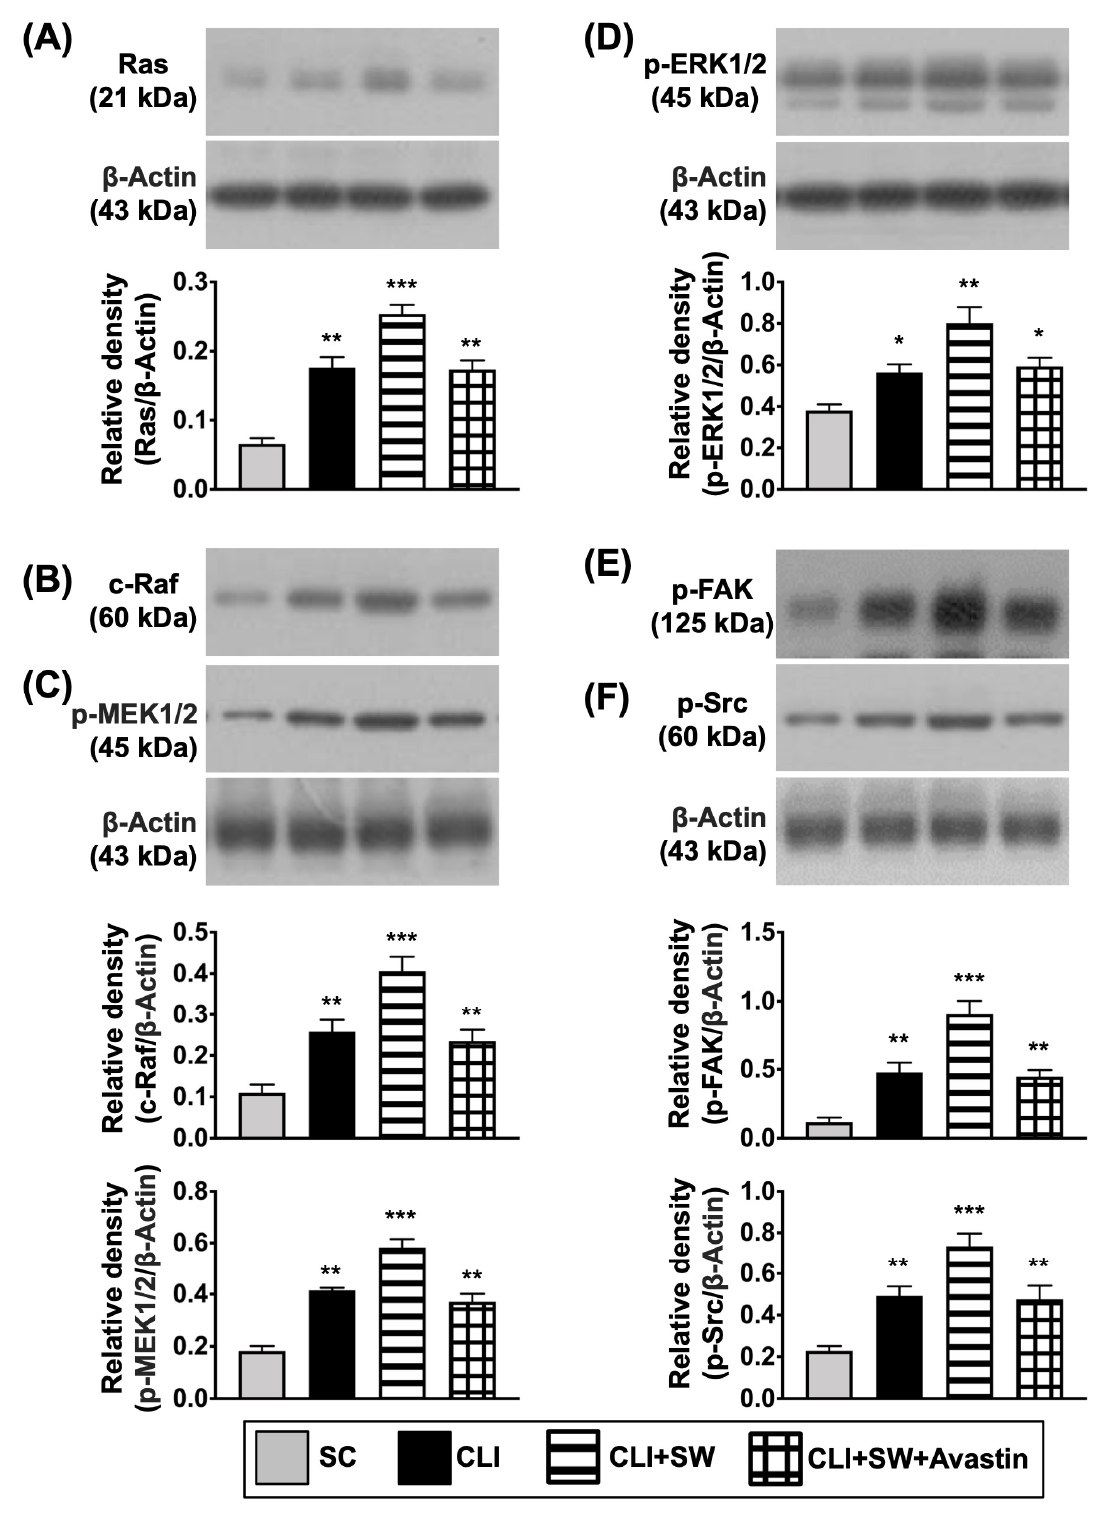
Figure 6. The protein expressions of cell proliferation and cell mobility signalings in CLI quadriceps muscle by day 14 after CLI induction. ( A–F ) Western blot analyses showed the results of protein expressions of Ras ( A ), c-Raf ( B ), phosphorylated (p)-MEK1/2 ( C ), p-ERK1/2 ( D ), p-focal adhesion kinase (p-FAK) ( E ) and p-Scr ( F ), * for p < 0.05, ** for p < 0.01, *** for p < 0.001. n = 6 for each group. SC = sham-operated control; SW = shock